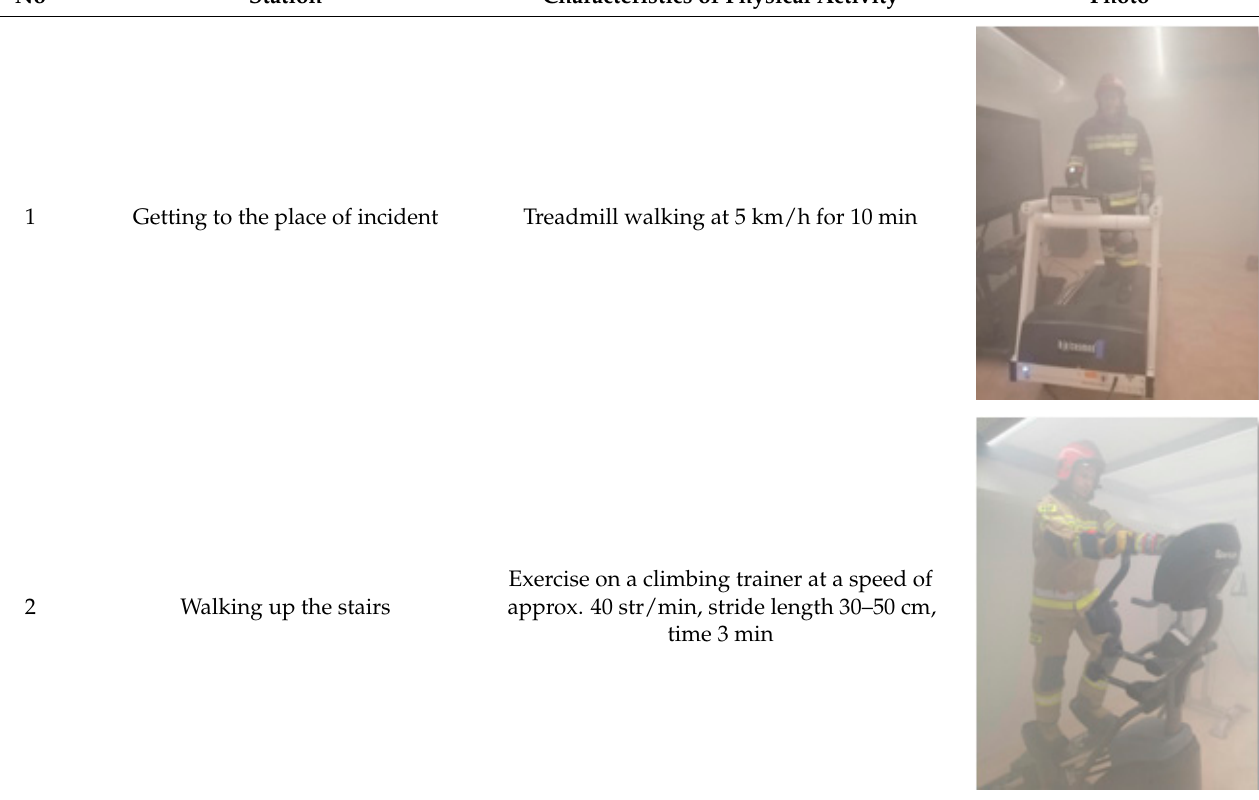
Table 2. Description of the stations with the characteristics of the physical activities performed. No Station